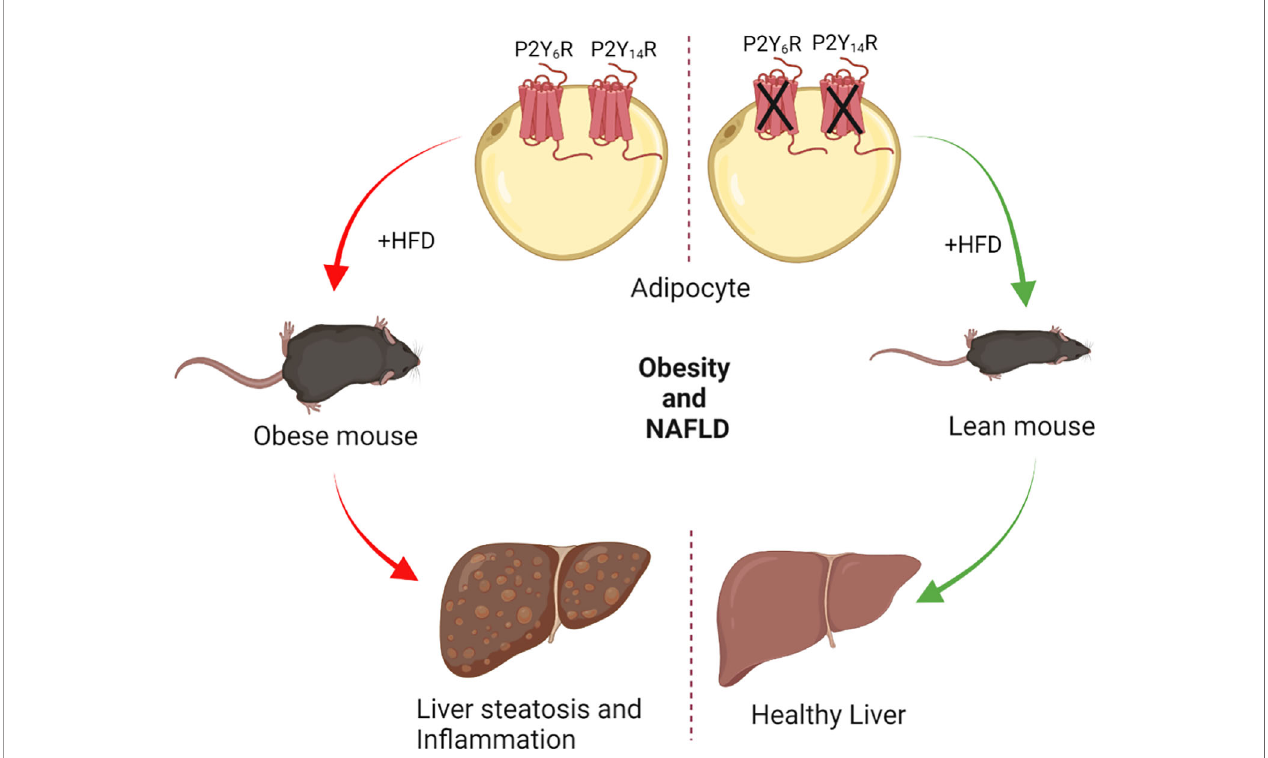
FIGURE 2 | Dysregulated purinergic signaling in adipocytes alleviates obesity and associated NAFLD. Lack of P2Y 6 R or P2Y 14 R speci fi cally in adipocytes protects against diet-induced obesity. Reduced fat mass prevented the ectopic deposition of lipids in the liver, decreasing hepatic steatosis. Hepatic in fl ammation was reduced in mice lacking P2Y 6 R or P2Y 14 R in adipocytes. Antagonists of P2Y 6 R and P2Y 14 R may prove bene fi cial for the treatment of obesity-associated